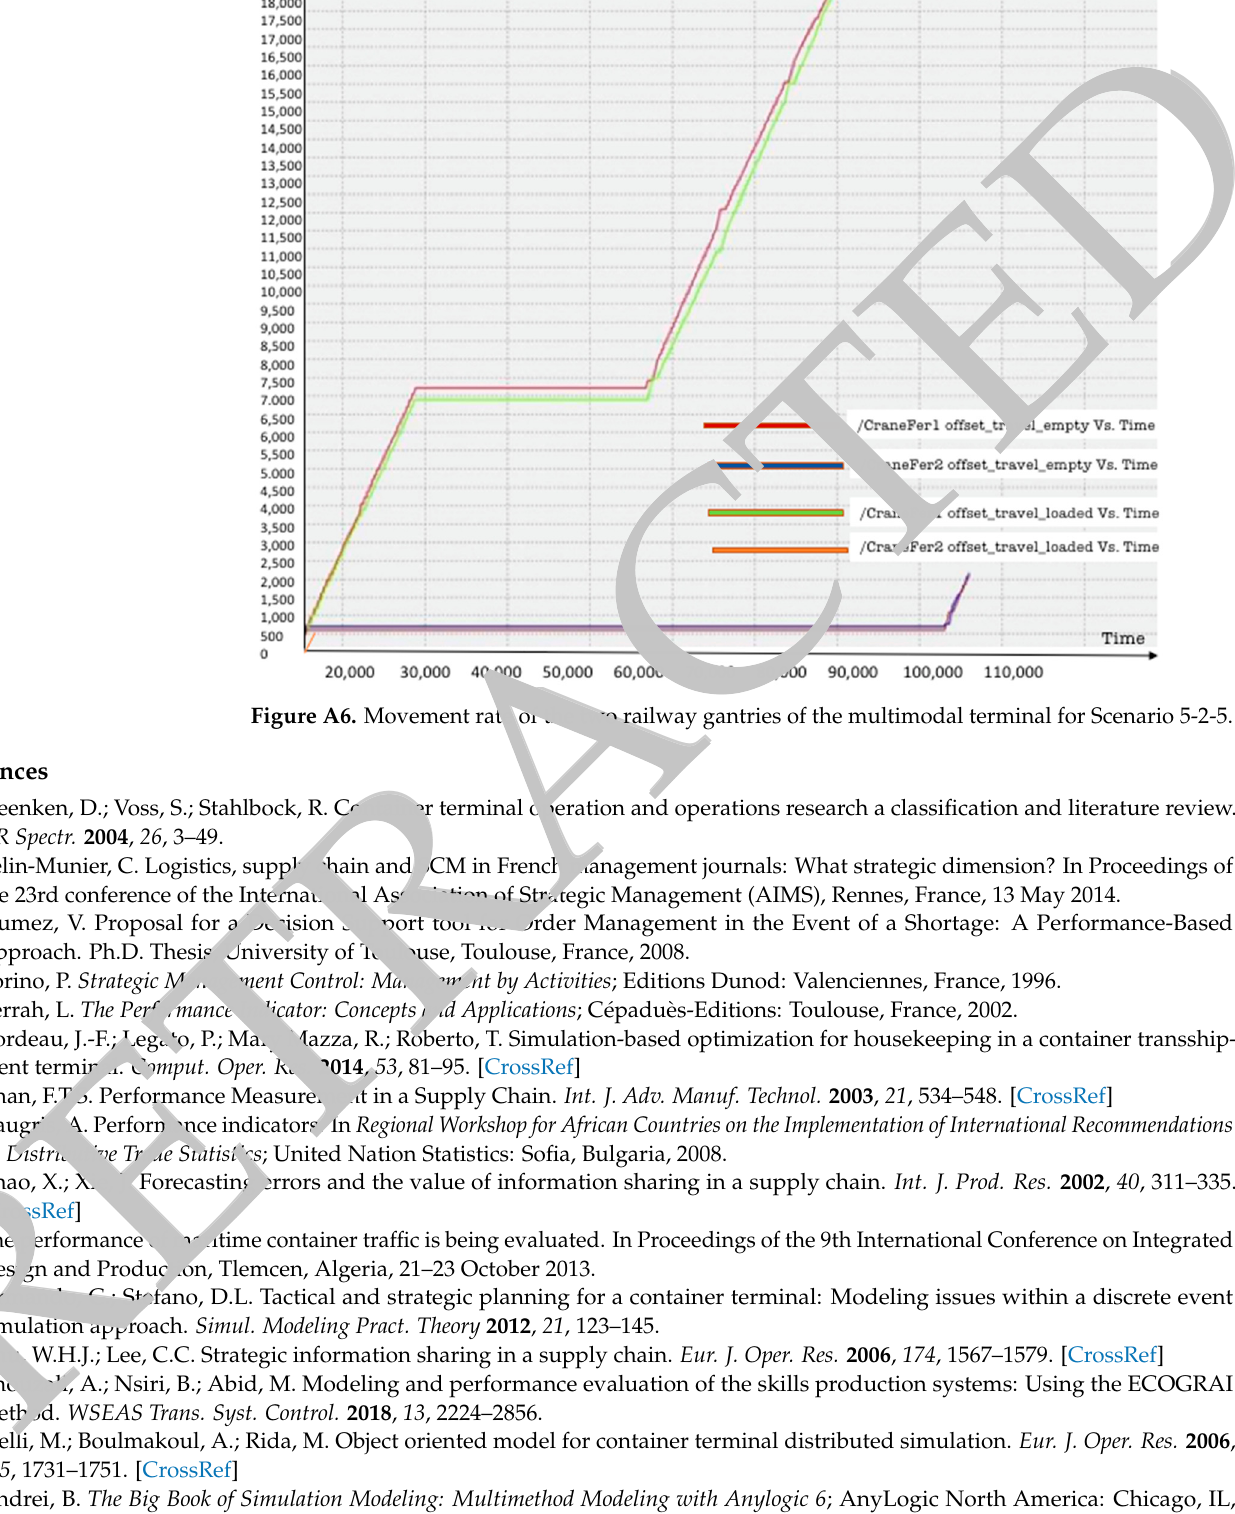
Figure A5. Movement rate of the two railway gantries of the multimodal terminal for Scenario 4-2- 4.